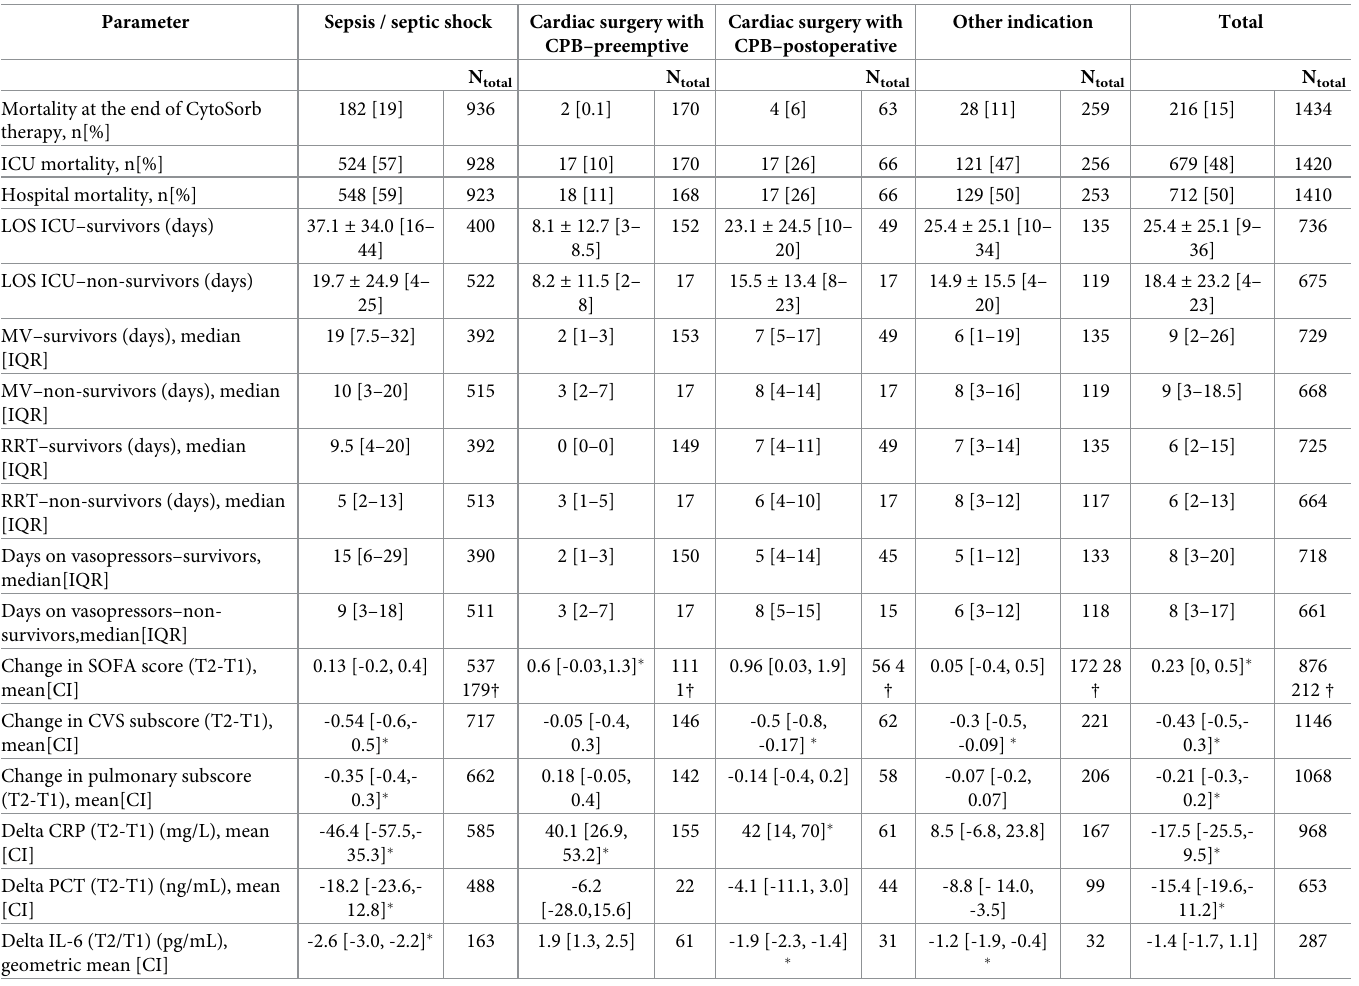
Table 2. Outcome